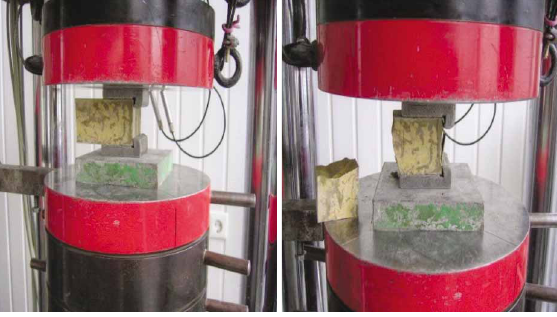
Fig. 3. A test on compressing